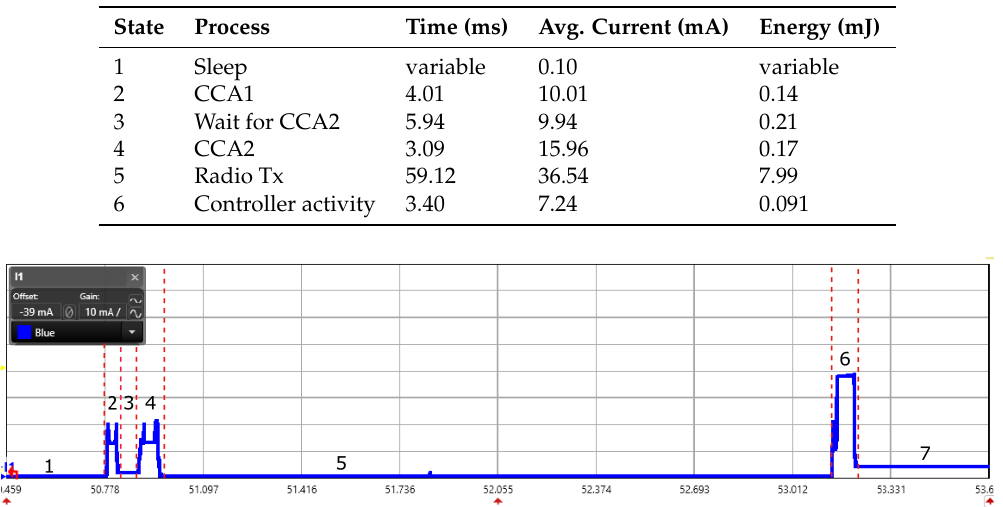
Table 4. Current composition split into different states of operation for DASH7 PULL mode.